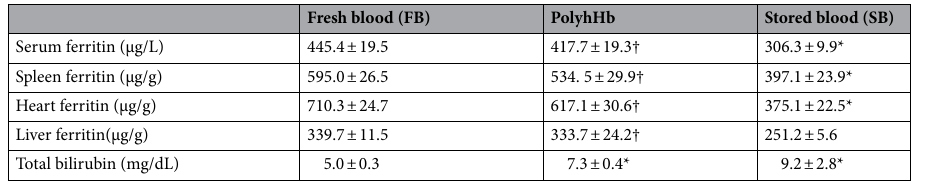
Table 2. Iron metabolism. Imbalanced iron metabolism was observed in the group resuscitated with stored blood, suggesting a reduced capacity for processing the excess of iron present in the circulation after resuscitation, and this imbalance could be associated with the organ injury observed in this group. Data was presented as the mean ± SE. * p < 0.05 versus Fresh Blood, † p < 0.05 versus Stored Blood. Statistical comparisons were completed using a one way—ANOVA; Tukey’s multiple comparison